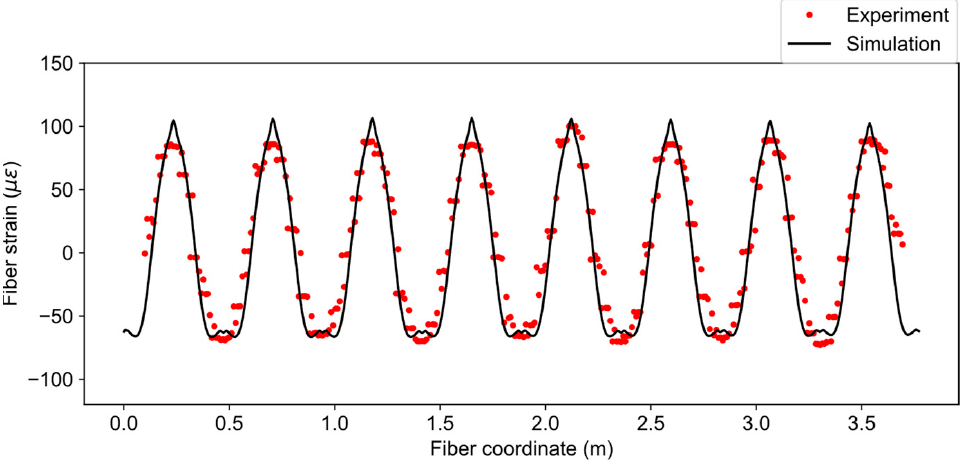
Figure 16. Optimized pressure distribution along the longitudinal direction of the pipe.